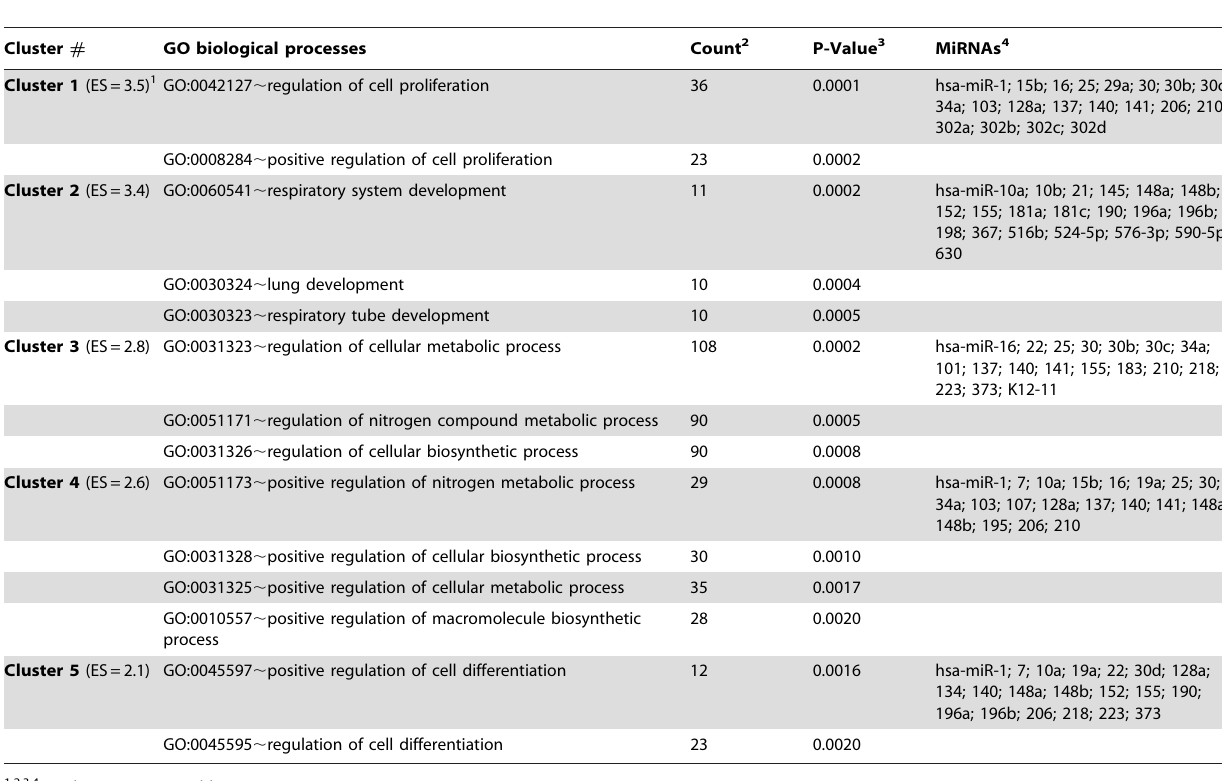
Table 2. Functional annotation clusters of enriched GO biological processes predicted to be suppressed by miRNA upregulation in senescent IMR90